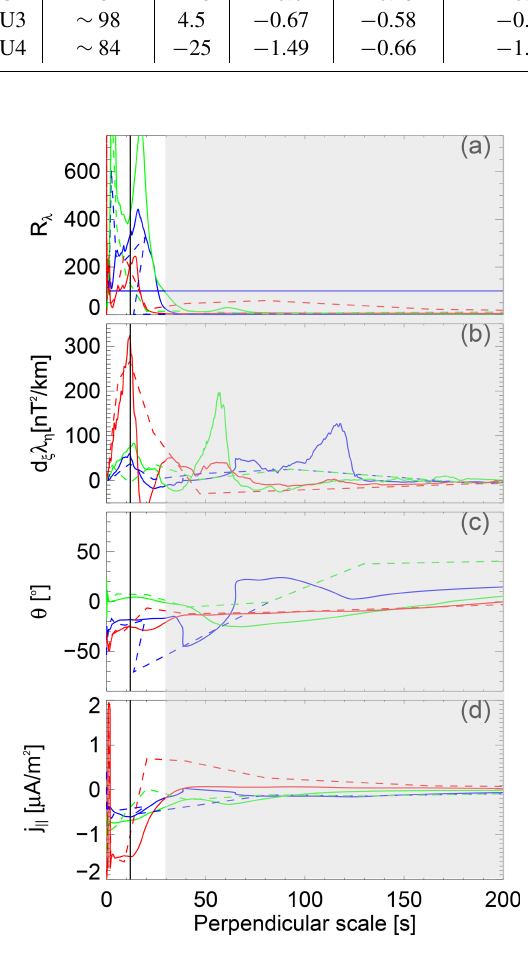
Figure 10. Same panels as in Fig. 6. Solid/dashed lines indicate the profiles for the linear-/logarithmic-scale sampling scheme. The pro- files are taken in the middle of the upward FACs located at 07:38:41 (blue), 07:39:09 (green), and 07:39:33 (red). These times are indi- cated by the vertical solid lines in Fig. 9.